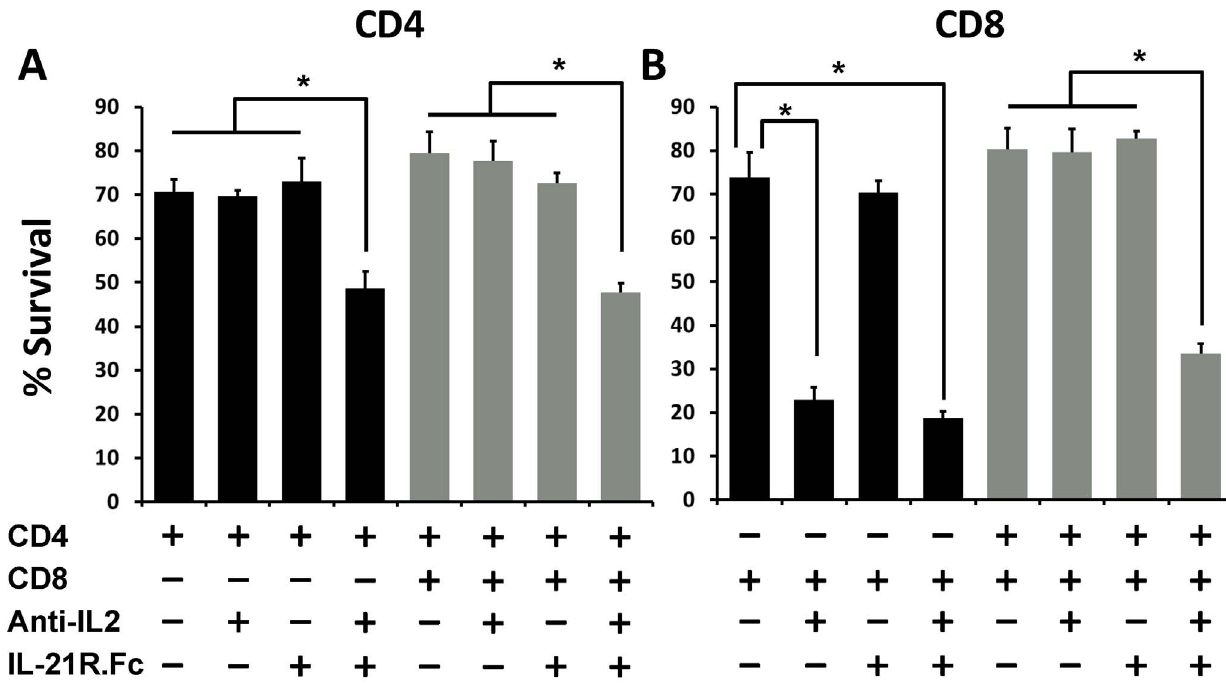
Figure 5. Neutralizing IL-2 and IL-21 simultaneously reduces the survival of both CD4 + and CD8 + T cells. CD4 + CD25 2 and CD8 + CD25 2 T cells were isolated from wild-type B6 mice, and were cultured together (2.5 6 10 4 cells/well from each population) or individually (5 6 10 4 cells/well) as indicated in a 96-well plate. The cells were stimulated with anti-CD3/CD28 mAbs in the presence or absence of anti-IL-2 and IL-21R.Fc as indicated. The cells were harvested at 48 hrs post-culture and subsequently stained for CD4, CD8 and PI for measuring cell survival. ( A ) The bars graph shows frequency of PI negative cells within the CD4 + T cell population when cultured alone ( black bars ) or with CD8 + T cells ( gray bars ). ( B ) Bars graph shows frequency of PI negative cells within CD8 + T cell population when cultured alone ( black bars ) or with CD4 + T cells ( gray bars ). The figure shows results from one representative experiment which was repeated three times with similar results. Bars indicate average value 6 SD obtained from three culture wells (technical triplicates) in each experimental group (*denotes p ,